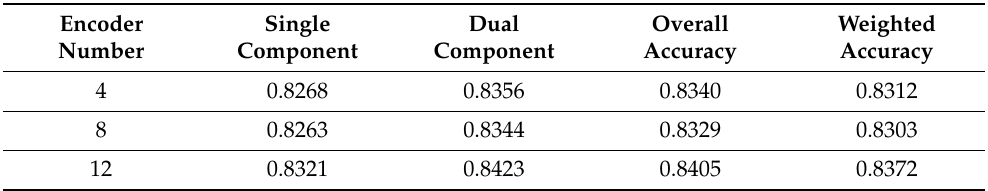
Table A3. The classification accuracy of testing dataset.